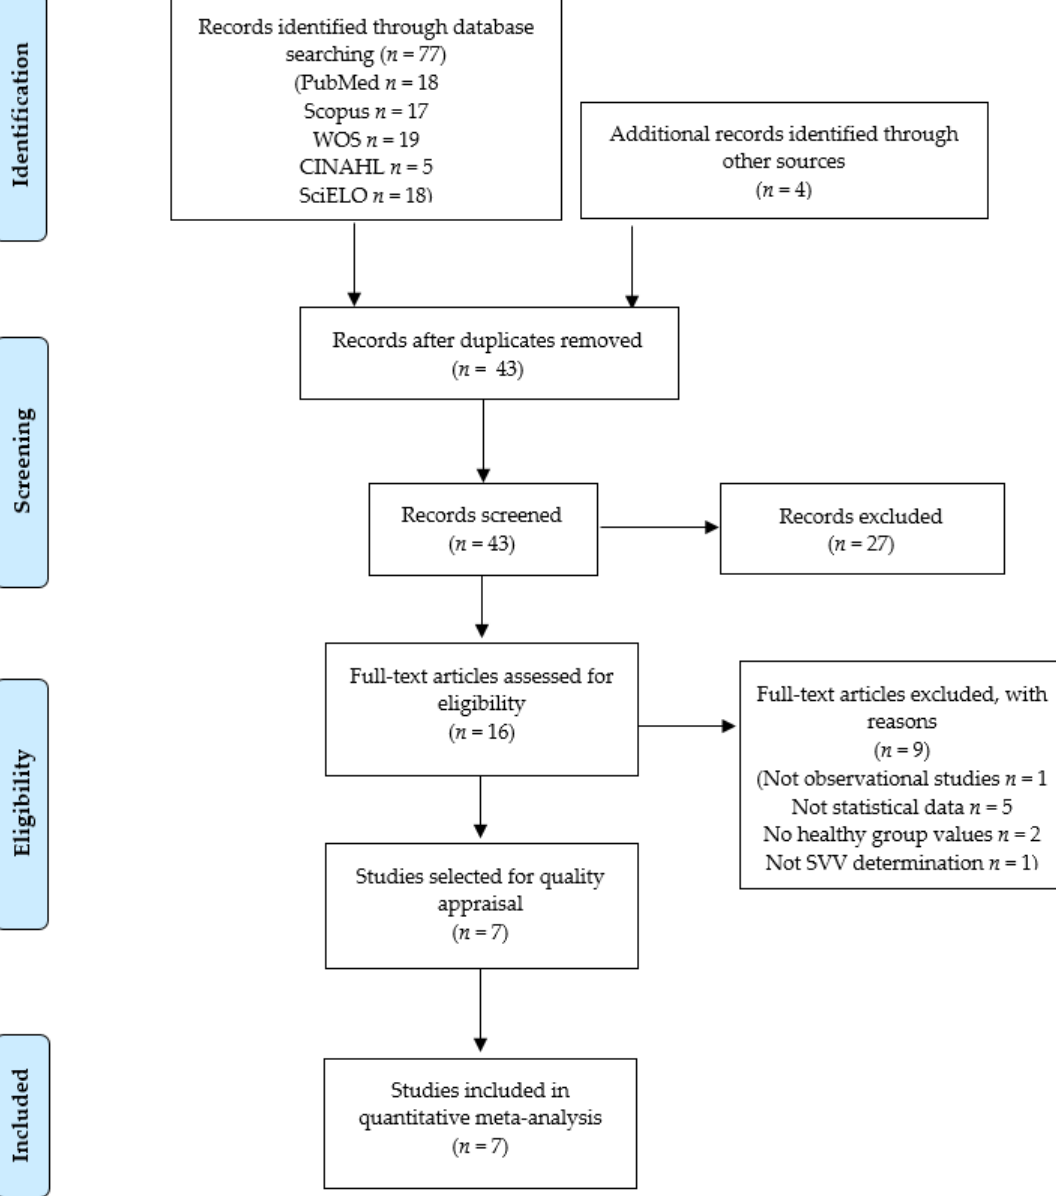
Figure 2. Preferred Reporting Items for Systematic Reviews and Meta-Analyses (PRISMA) flow chart.